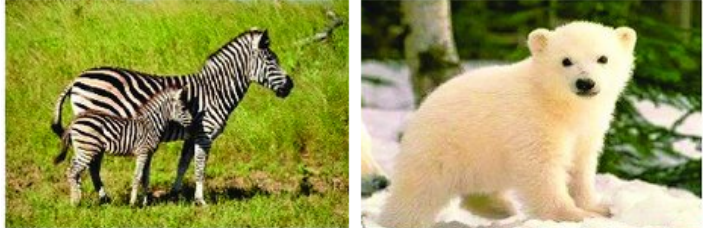
Figure 2. Examples from Animals with Attributes (AWA)